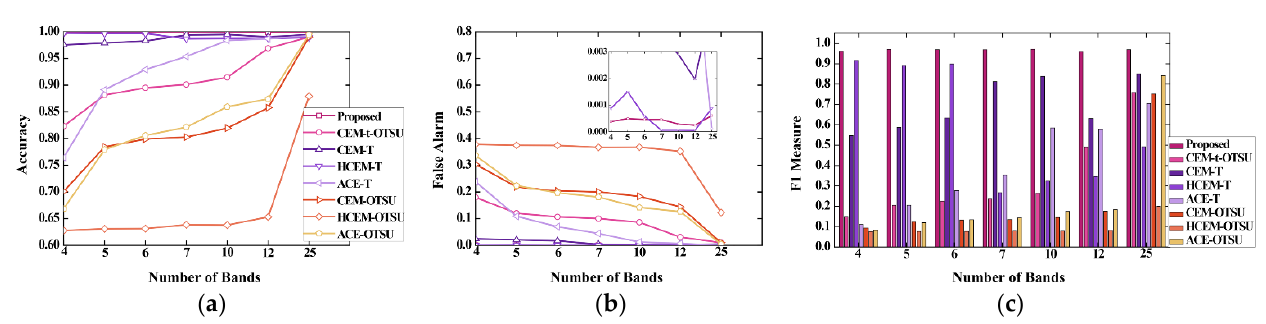
Figure 19. The quantitative comparison of ASRC-net detection results in the BF scene at 16 mm focal length; ( a ) The curves of